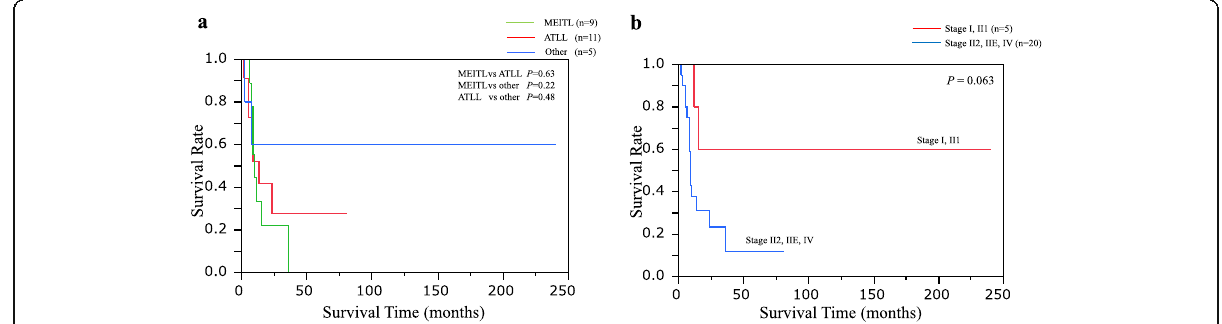
Fig. 4 Overall survival (OS) curves in 25 patients with colorectal TNKCL. a 50% OS rates of MEITL, ATLL and other group were 9.5 months, 9 months, and more than 240 months, respectively. There was no statistical difference between MEITL and ATLL. b The 50% OS of five patients with primary colorectal TNKCL in early stages (I or II1) was over 240 months, and that of 20 patients in advanced stages was 8.5 months. There was no statistical difference between the two groups ( P =